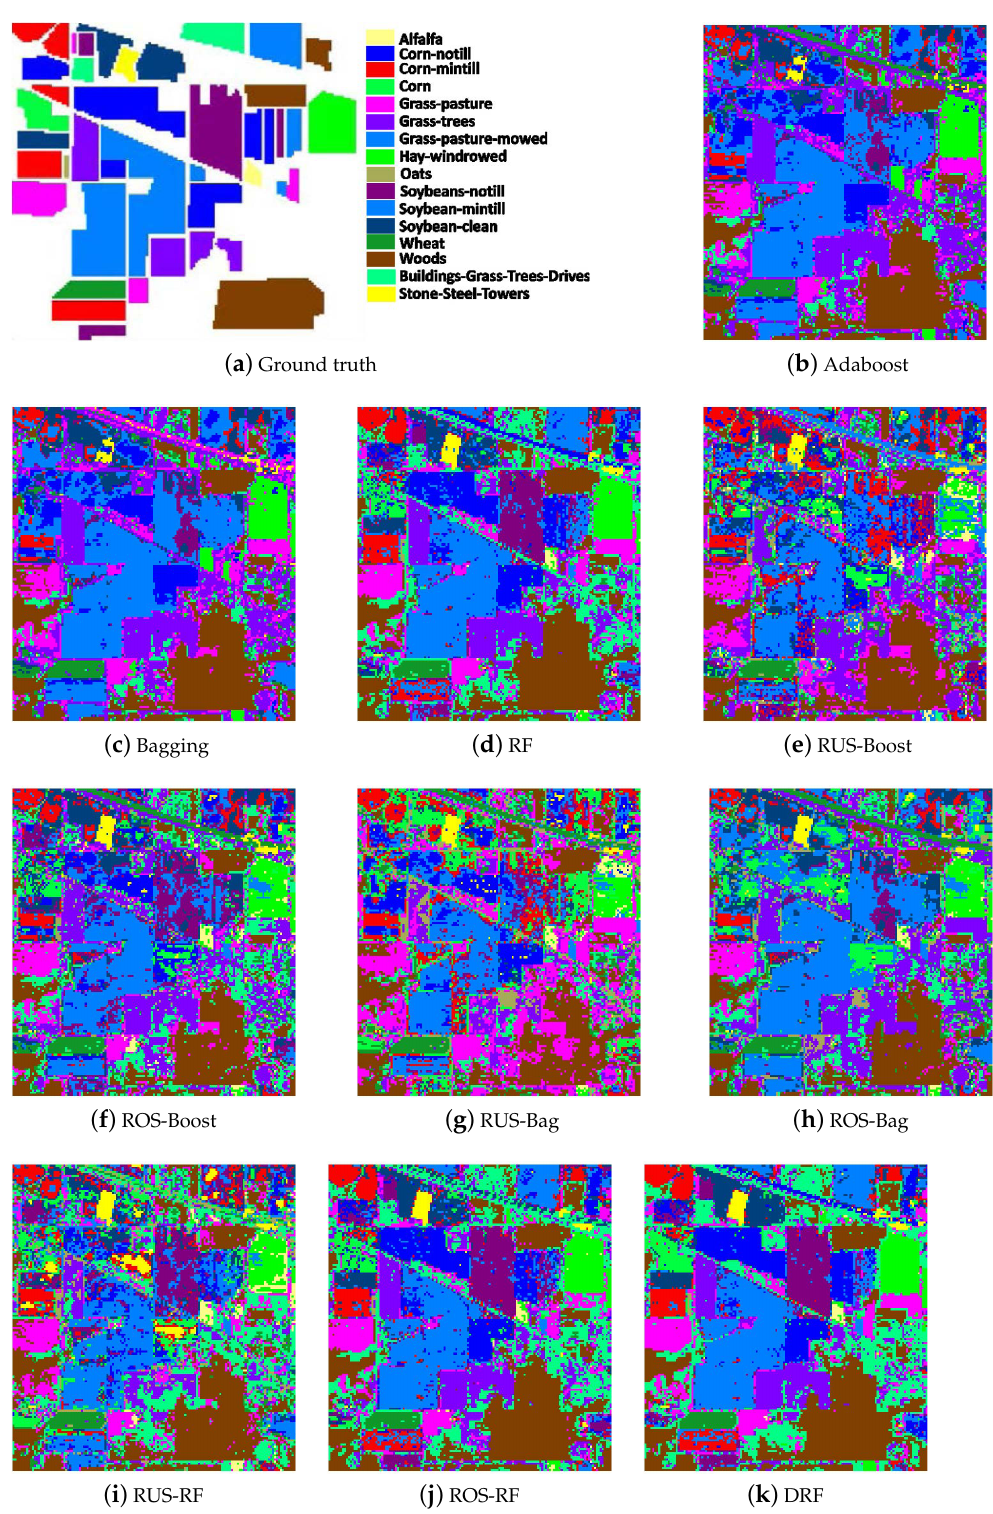
Figure 3. Ground truth, classification maps of Adaboost, Bagging, random forest, random undersam- pling combined, random oversampling combined Adaboost, Bagging, and random forest, and the proposed double random forest DRF, on the hyperspectral data Salinas